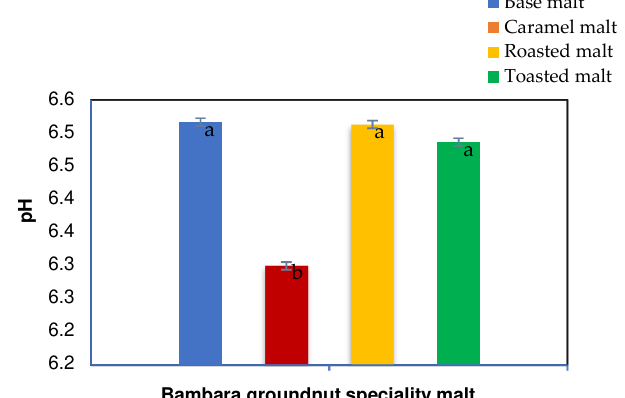
Figure 3. pH characteristics of Bambara groundnut speciality malt. Values are mean ± standard deviation of triplicate values; mean values on the bars with different letters are significantly different ( p < 0.05).